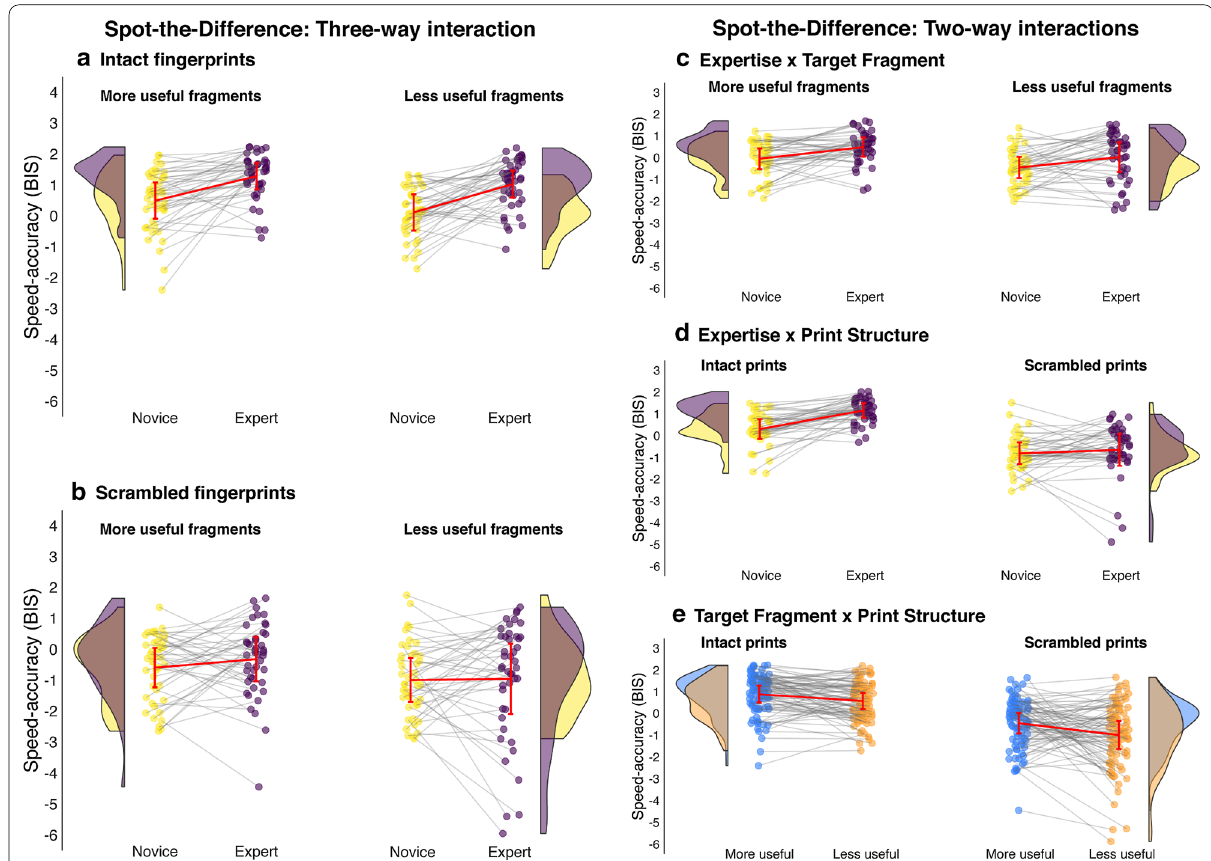
Fig. 6 A visualization of the interactions for the speed–accuracy data (measured using Balanced Integration Scores) in the Spot-the-Difference task. We present the three-way interaction (left) comparing experts and novices for each type of change for the intact trials ( a ) and scrambled trials ( b ). We also present all three two-way interactions ( c – e ). In all but panel e , the expert data are colored purple and the novice data yellow. Each participant’s individual performance is represented by the small circles, with grey lines connecting every expert to their yoked novice ‘twin’. The distributions depict the overlap in each group’s performance, the red error bars represent the confidence interval around each cell mean, and a red line connects the group means for each cell. e Depicts the final two-way interaction comparing performance at finding more useful changes (blue) and less useful changes (orange) overall with each participant’s data connected by a grey